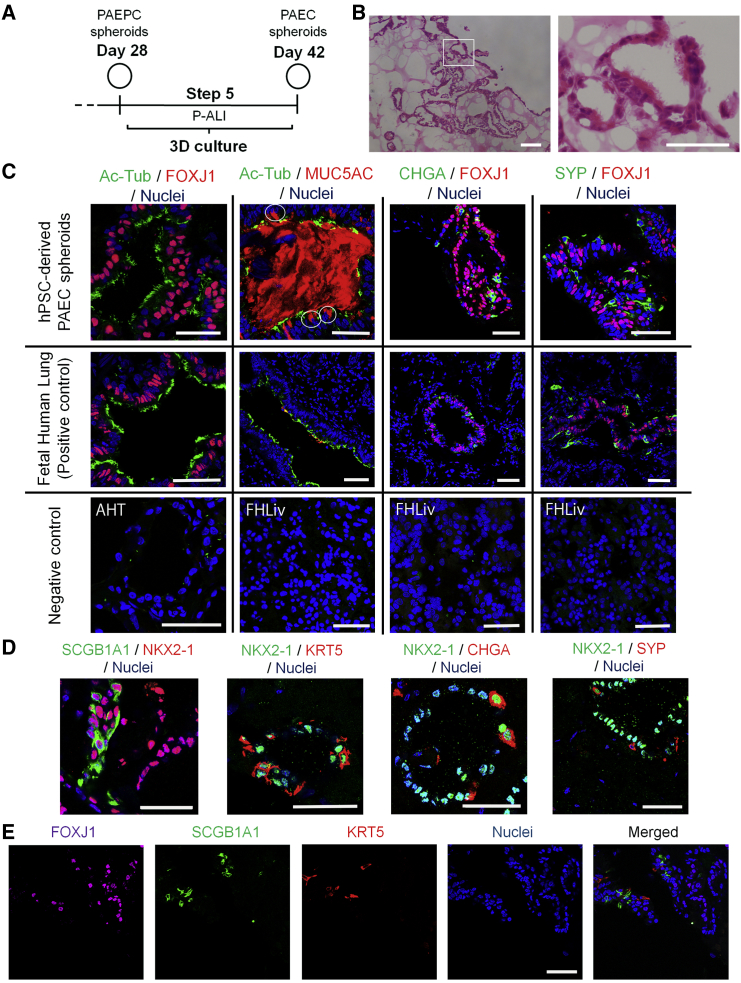
Derivation of PAECs from PAEPC Spheroids(A) A schematic illustration of the induction of PAECs from hPSC-derived PAEPC spheroids.(B) H&E staining of PAEC spheroids (201B7 hiPSCs) on day 42 shows spheroids (left) and clusters of MCACs in a magnified view (right).(C) Double immunostaining of PAEC spheroids (201B7 hiPSCs) on day 42. Fetal human lung was shown as a positive control. Adult human thyroid (AHT) was shown as a negative control for Ac-Tub and FOXJ1, whereas fetal human liver (FHLiv) was shown as a negative control for Ac-Tub, FOXJ1, MUC5AC, SYP, and CHGA. The white circle indicates MUC5AC+ cells.(D) Double immunostaining of induced PAEC spheroids (201B7 hiPSCs) on day 42. SCGB1A1, KRT5, CHGA, and SYP were detected in NKX2-1+ cells.(E) Triple immunostaining of PAEC spheroids (201B7 hiPSCs) on day 42. FOXJ1, SCGB1A1, and KRT5 were detected in the different cells.Scale bars, 50 μm. See also Figure S2 and Table S2.